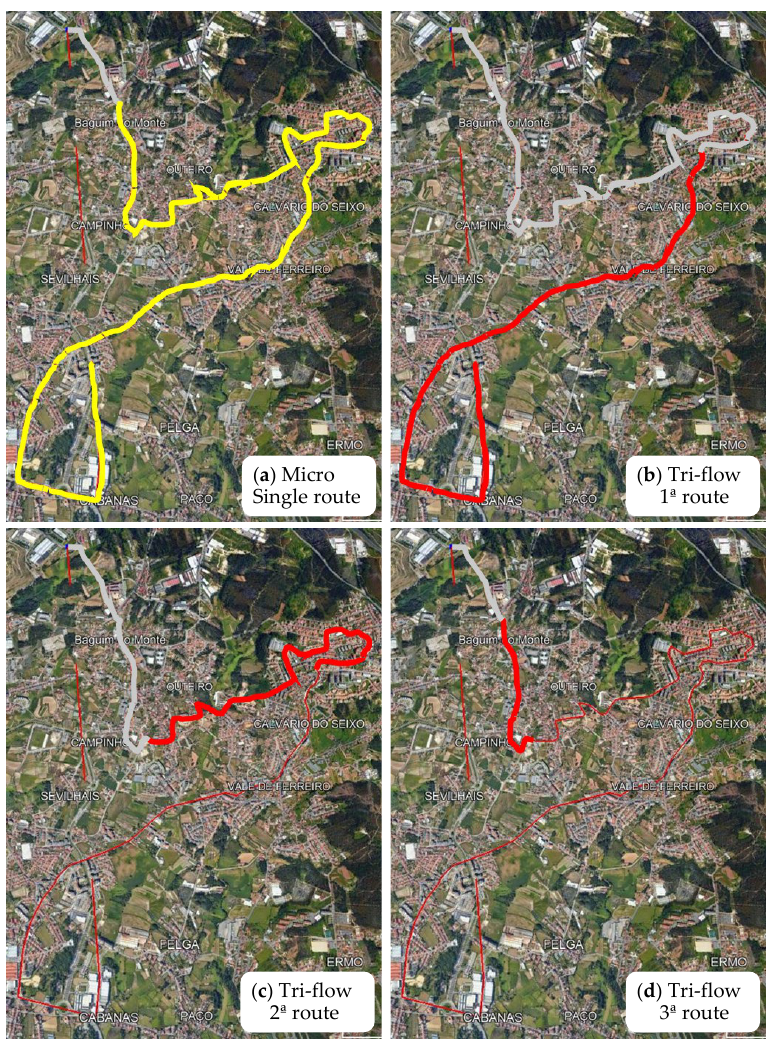
Figure 12. Collection and transport routes for: ( a ) Micro; ( b – d ) Tri-flow vehicle.